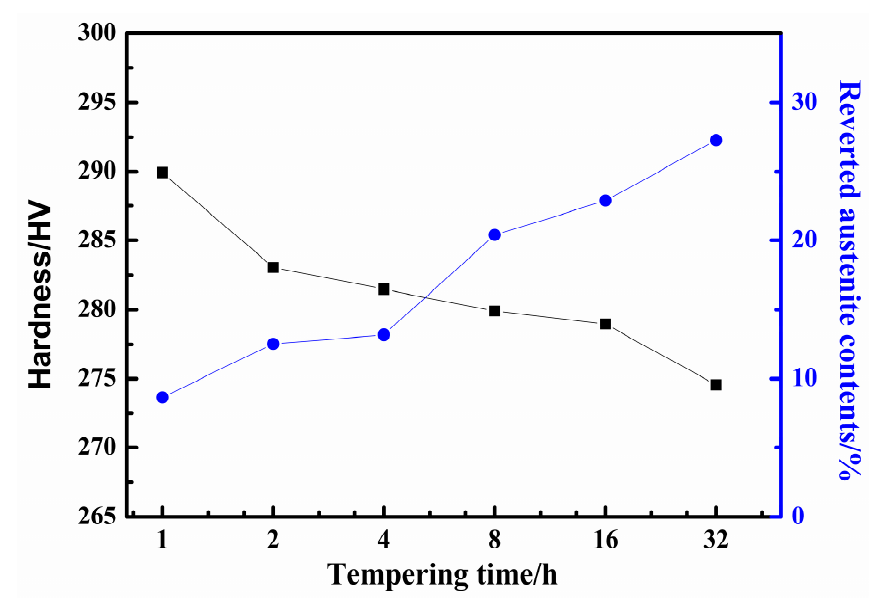
Figure 3. The variation of micro hardness and reverted austenite tempered at 620 °C for different tempering times.